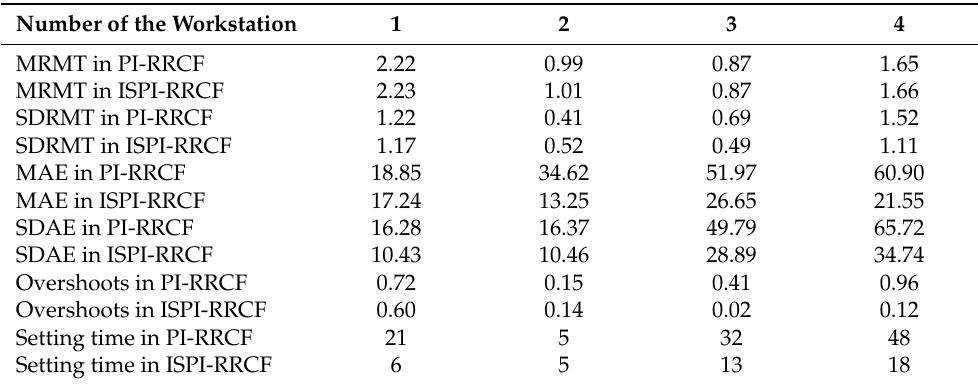
Table 3. Statistics of the capacity control